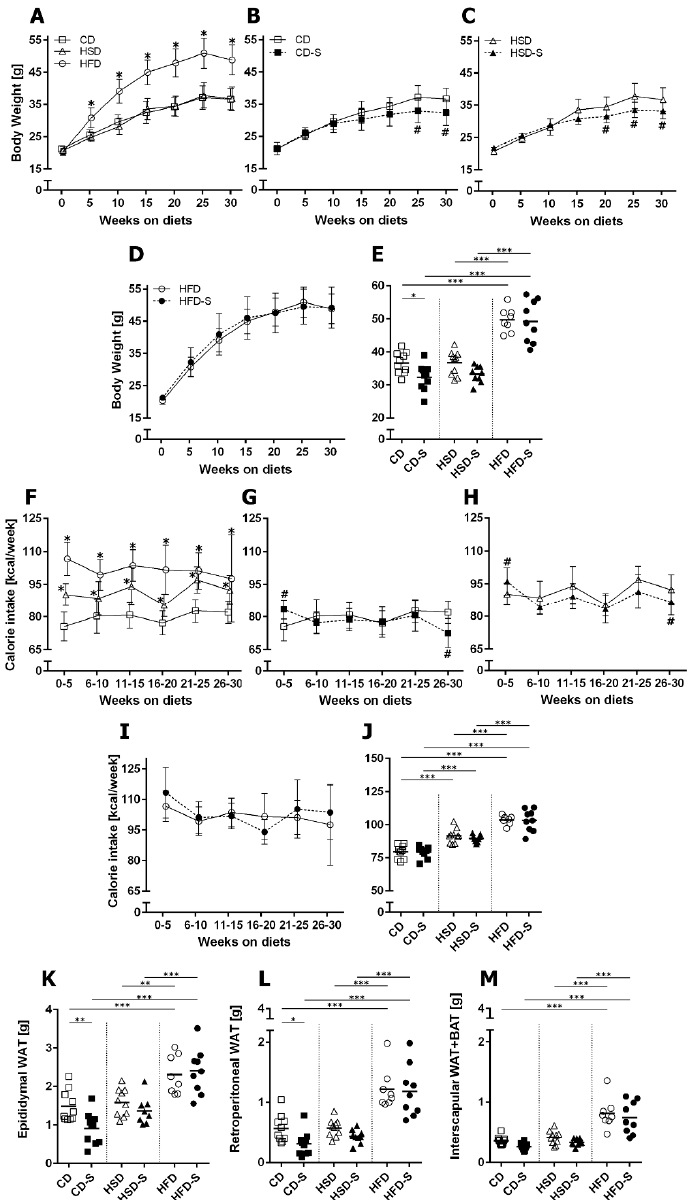
Figure 2. Effects of diets and spermidine on body weight, calorie intake and fat depots. ( A ) Diet-related effects on body weight gain. ( B – D ) Spermidine-related effects on body weight gain in respective diet groups. ( E ) Final body weights after 30 weeks. ( F ) Diet-related effects on calorie